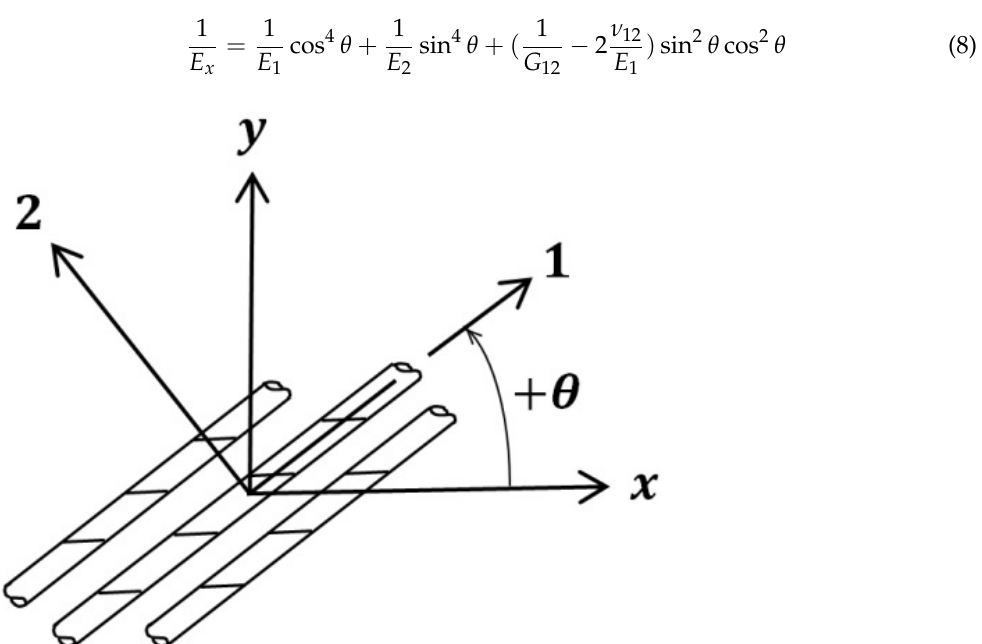
Table 3. Mechanical properties of FRP laminates used in parametric studies. Based on Table 2, specimen C1E1T1 means a concrete column with f (cid:48) which was confined with the FRP wrap having E frp = 50 GPa and t frp = 0.2 mm, for